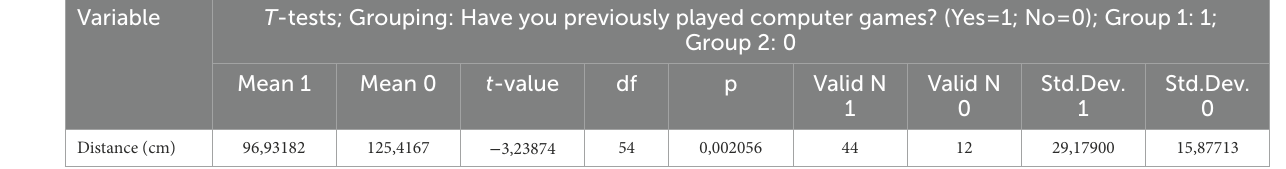
TABLE 4 Influence of previous experience with computer games on communication distance. Variable